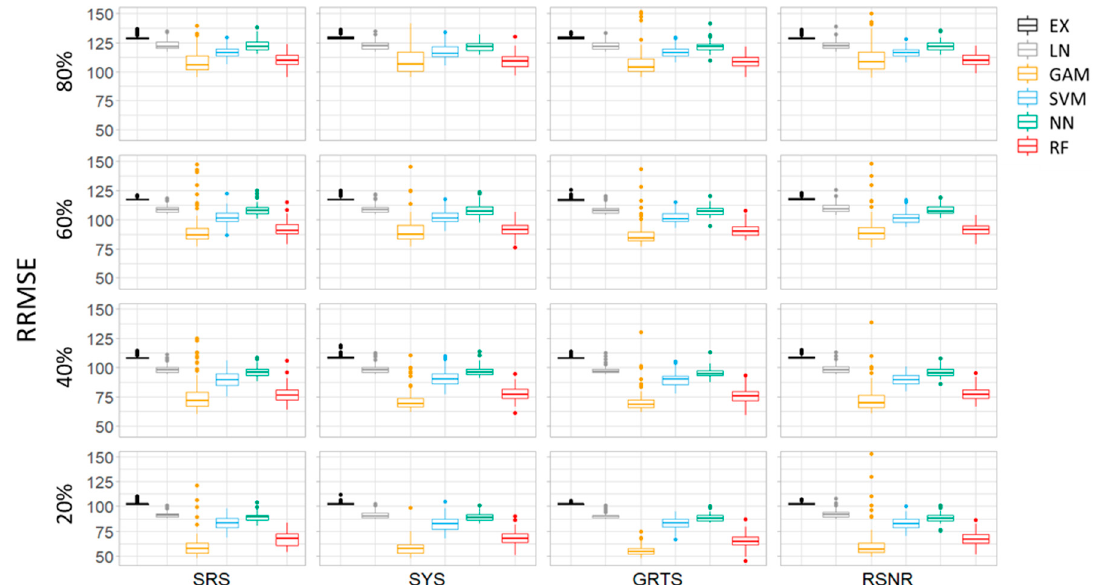
Figure 6. Relative RMSE (RRMSE) for expansion and fully-specified model-based estimates derived from 100 iterations of nonlinear trend response surfaces. Response surfaces incorporated random errors at 20%, 40%, 60%, and 80% of the total nonlinear SC1 image standard deviation. Column and row titles identify sample designs and proportion of SC1 standard deviation used in response surfaces. Ex = expansion; LN = linear; GAM = general additive model; SVM = support vector machine; NN = neural networks; RF = random forests; SRS = simple random sample; SYS = systematic random sample; GRTS generalized random tessellation stratified; and RSNR = random sample near roads.